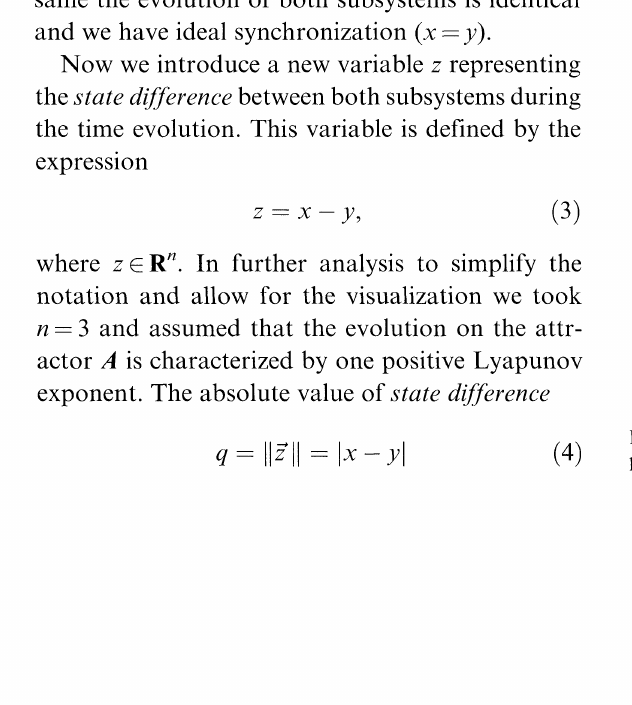
FIGURE The image of the vector equation (Eq. (5)) in phase